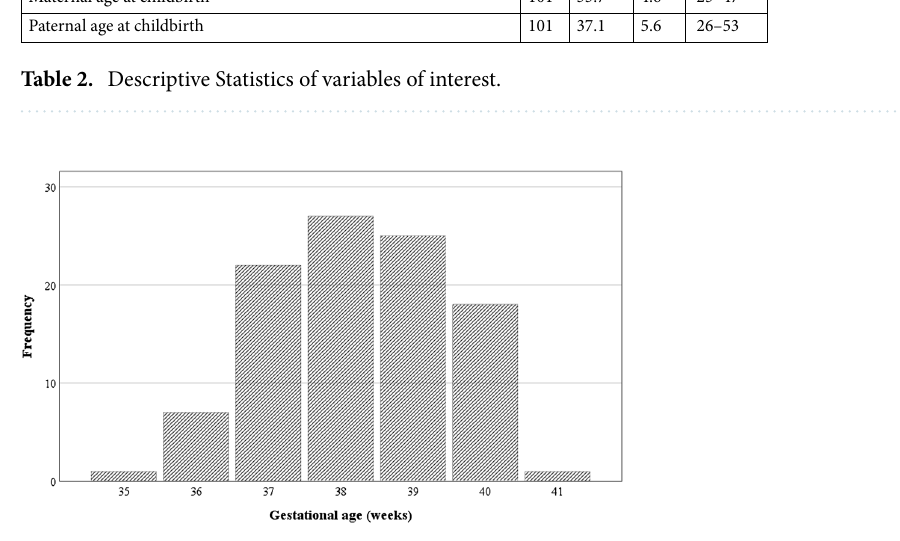
Figure 1. Bar chart representing the distribution of the frequencies of gestational age in the 105 participants with Down